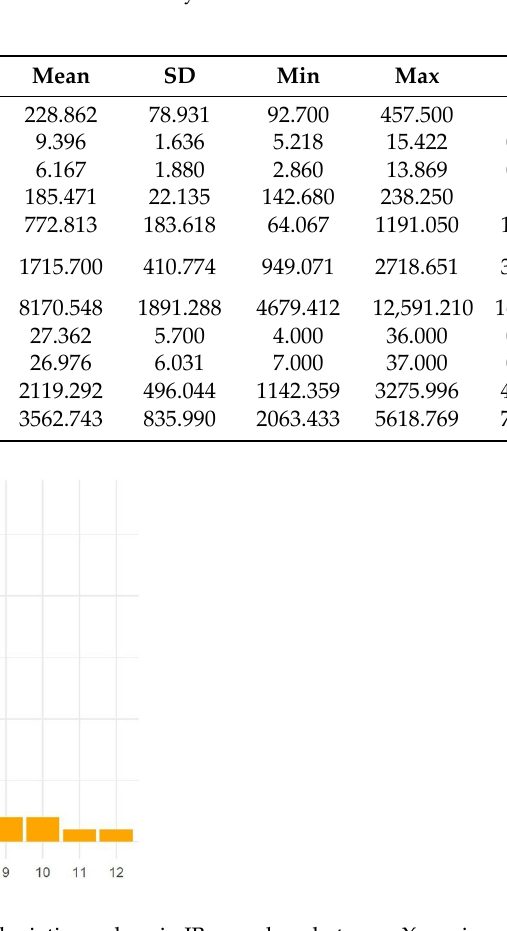
Figure 4. The relationship between tambaqui ( A ) IB number and ( B ) length in dissection and X-ray imaging methods (R Pearson, p < 0.001). 3.2. Predictive Models of IBs Based on X-Ray Imaging in Tambaqui We have found a moderate positive correlation between the total number of IBs by X-ray imaging and dissection methods for overall morphometric characters, varying from 0.48 ( p < 0.001) to 0.54 ( p < 0.001). Strong and positive correlations were demonstrated between IBs length by X-ray and zone areas (THU, THS and TOA; R > 0.70, p < 0.001), and there was also a moderate relationship to body weight and standard length (R = 0.68 and 0.69, p < 0.001) (Figure 5).